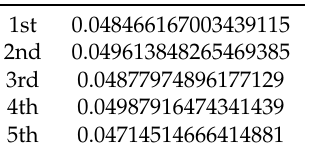
Table 2. NRMSD in the 5 different test samples based on the model in Table